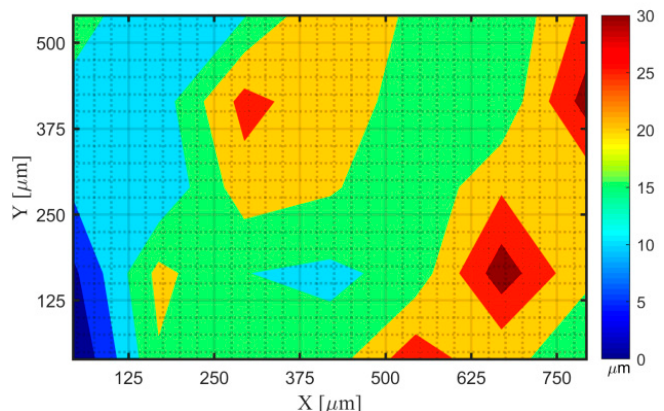
Figure 12. Contour of the Euclidean residuals between each certified and measured points. Electronics 2019 , 8 , 1217